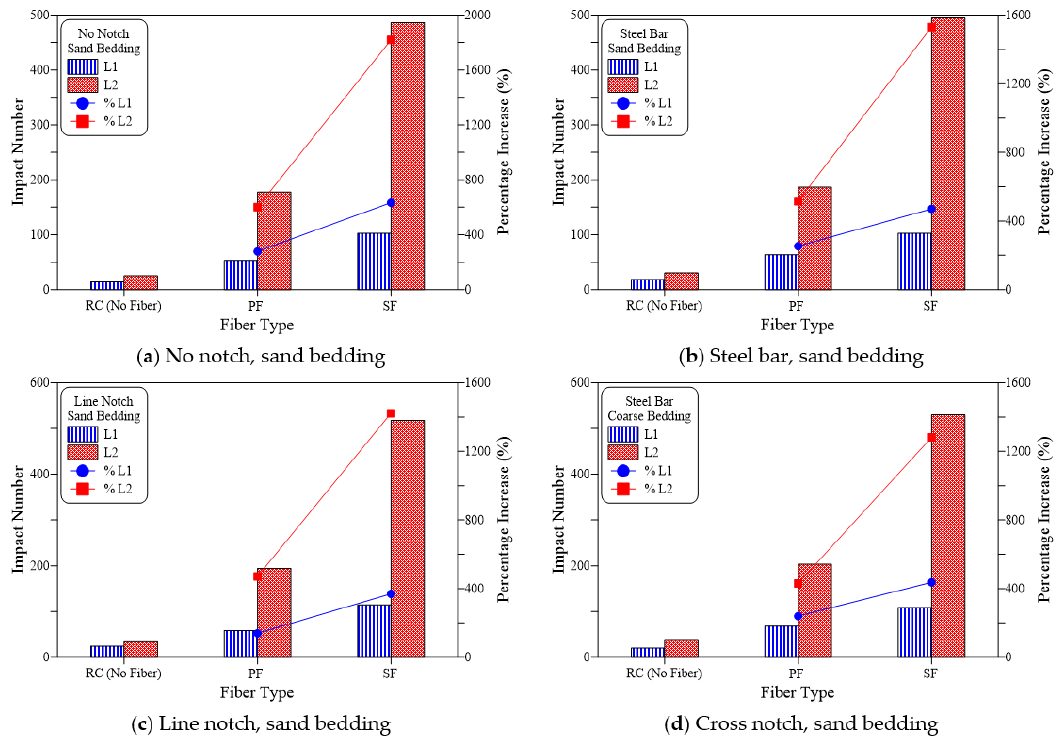
Figure 10. Fiber type effect on cracking and failure impact numbers of sand bedding specimens. ( a ) No notch, sand bedding, ( b ) Steel bar, sand bedding ( c ) Line notch, sand bedding ( d ) Cross notch, sand